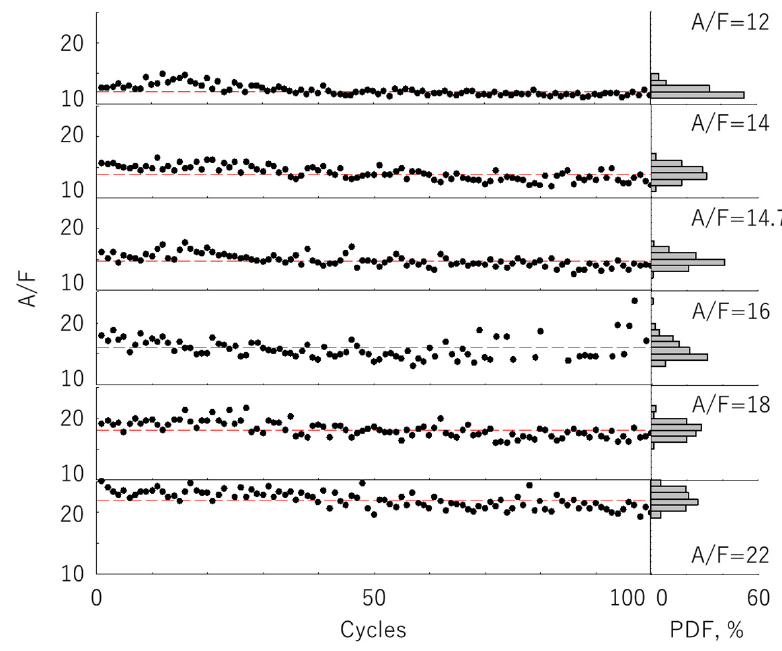
Figure 15. Cyclic variation of measured A/F and C spectrum intensity.